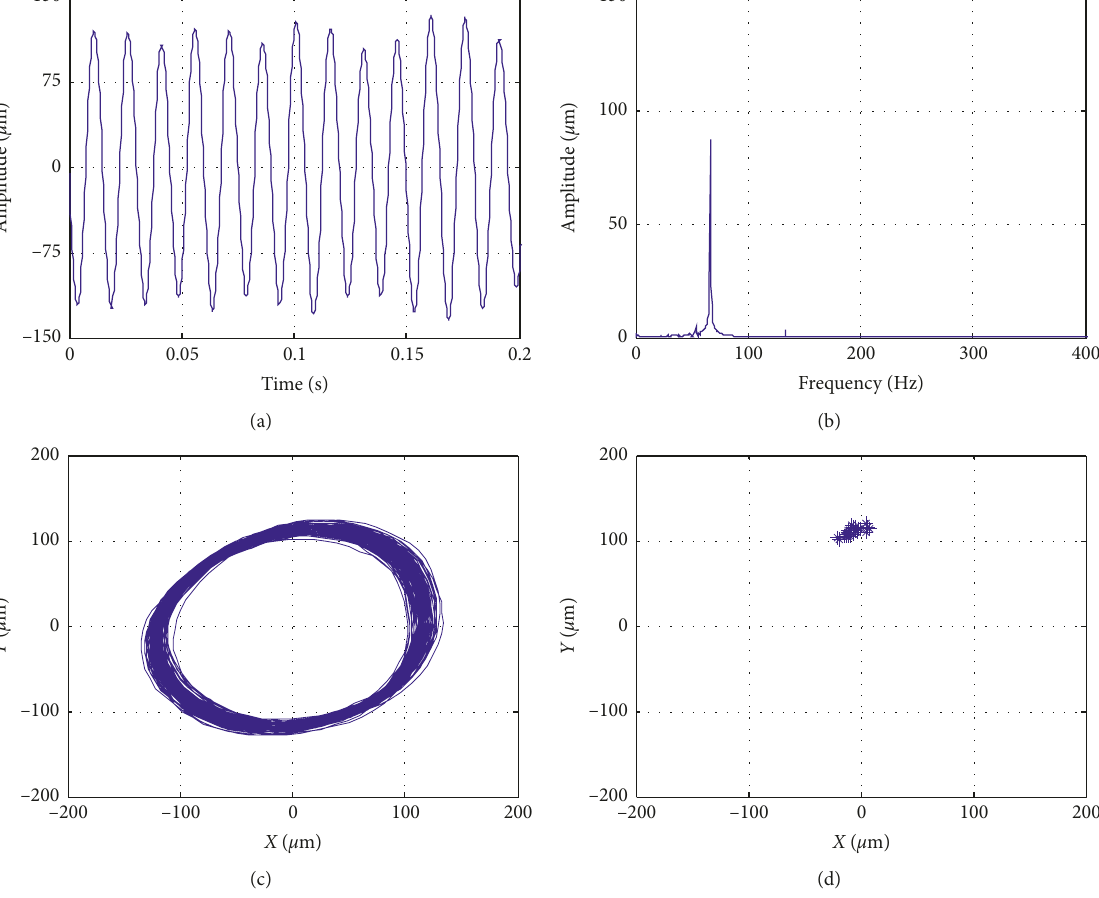
Figure 9: Normal state at 4000r/min. (a) time-domain waveform. (b) spectrum graph. (c) axis orbit. (d) Poincare